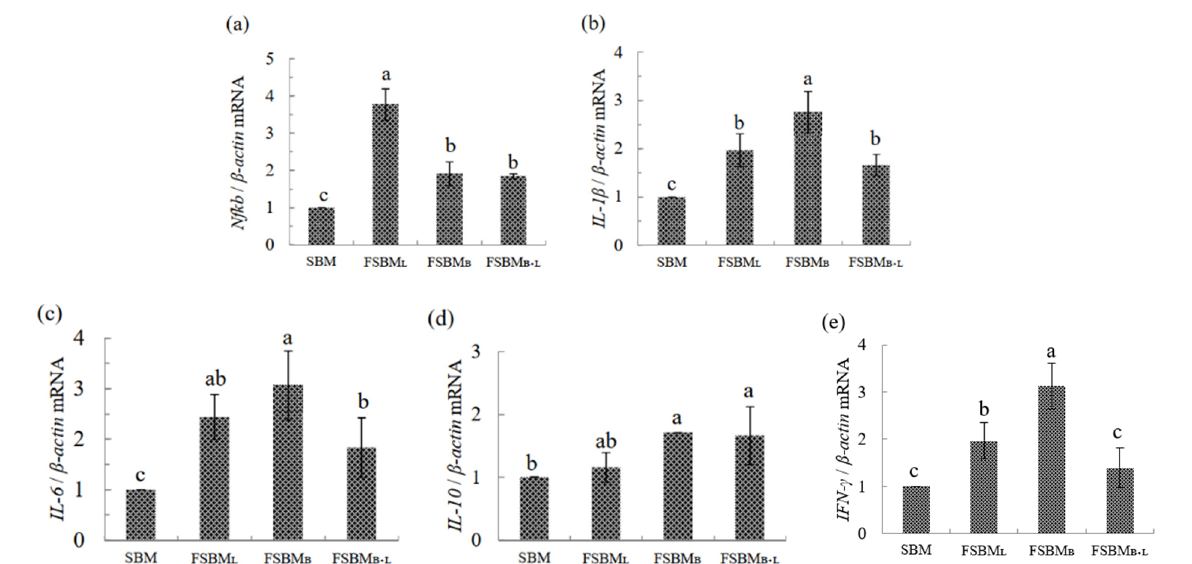
Figure 5. Effect of two-stage FSBM on jejunum’ s relative mRNA expression of genes related to NF- κ B ( a ), IL-1 β ( b ), IL-6 ( c ), IL-10 ( d ), and IFN- γ ( e ) of 35 day-old broilers. Each value represents the mean ± standard deviation (n = 5). a–c Means within a row with different letters differed significantly ( p < 0.05). SBM: Soybean meal; FSBM L : commercial control; FSBM B : SBM one-stage fermented by Bv; FSBM B+L : SBM two-stage fermented by Bv and Lb.